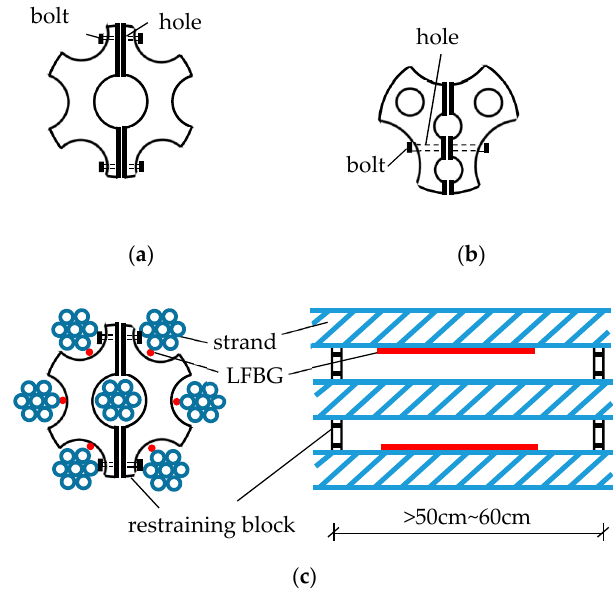
Figure 3. Sketches of the restraining block for ( a ) 7-strand tendon; ( b ) 3-strand tendon; and ( c ) for separating adjacent strands.